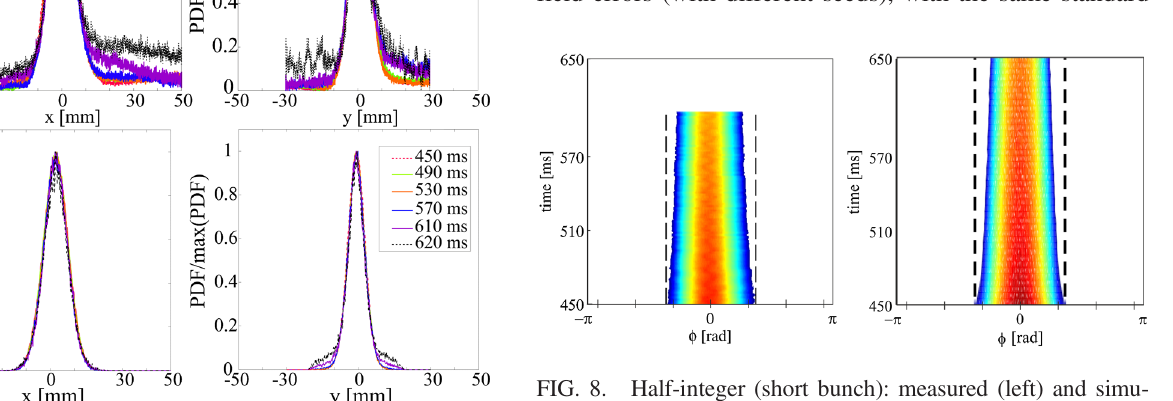
FIG. 8. Half-integer (short bunch): measured (left) and simu- lated (right) waterfall color plot in the time window [450 – 605] ms. The color code is the particle density (blue, low density — red, high density). The comparison of the behavior with the vertical dashed black lines puts in evidence the bunch